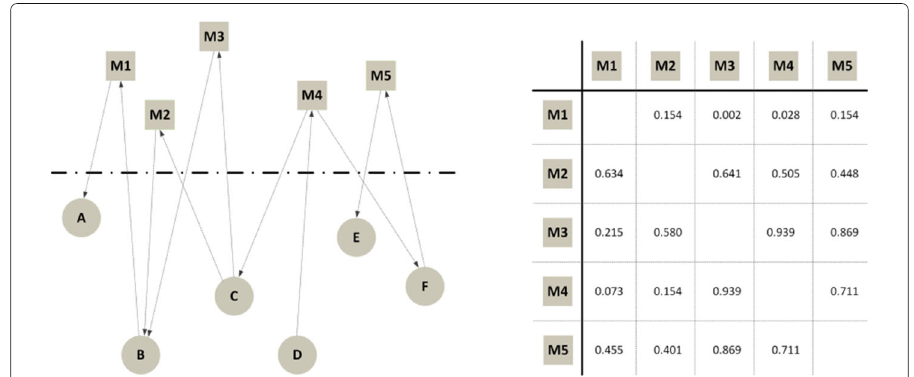
Fig. 8 Continuous approach: distance-based. ( left ) A temporal text network with 6 actors — circles — and 5 messages — squares; ( right ) a messages’ distance matrix is obtained from the network topology and time